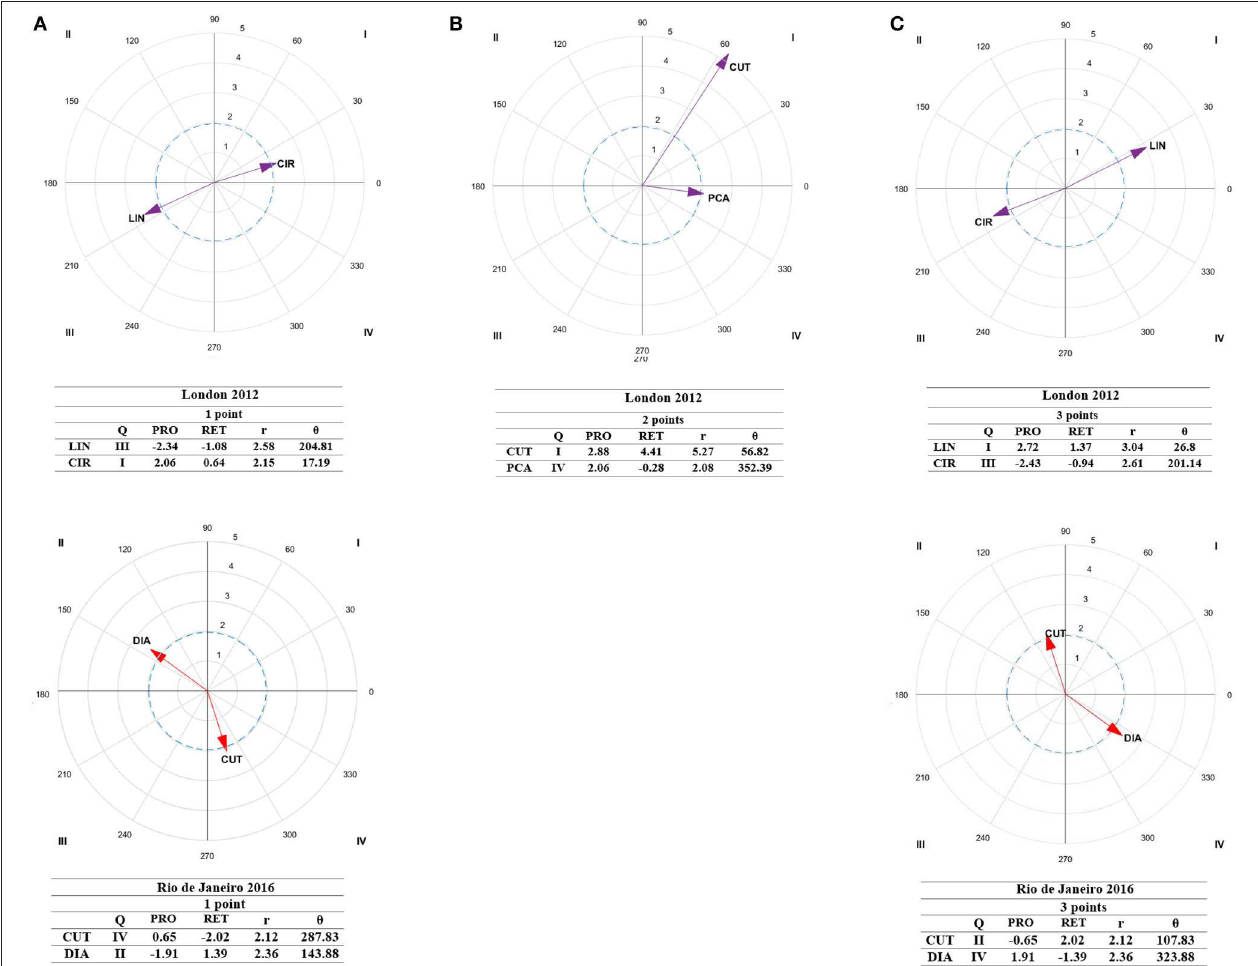
FIGURE 3 | Representation of behavioral maps for 1-point (A) , 2-point (B) , and 3-point (C) effective actions as focal behavior for 2012 (purple) and 2016 (red) tournaments. The behavioral map was represented divided into four quadrants, with each of the conditioned categories as vectors in the axis X/Y and their respective coordinates Z sum prospective (X) and Z sum retrospective (Y). Significate vectors (Radium > 1.96), Zsum values, prospective (pros.) and retrospective (retr.) perspectives, quadrants (Q), radium length (r), and vector angle ( θ ) are represented. CUT, Cuts; DIA, Direct Attack; PCA, Posterior Counterattack; LIN, linear technique; CIR, Circular